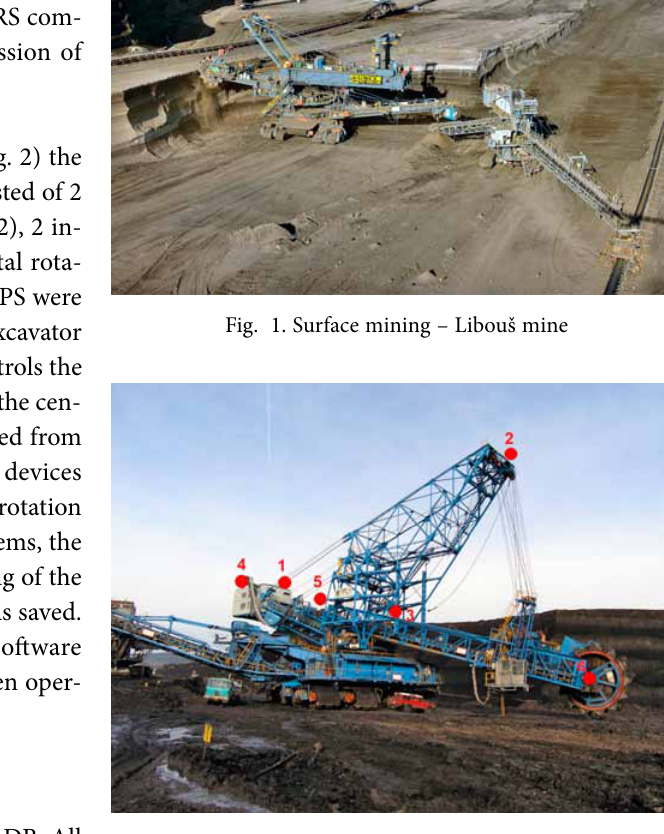
Fig. 2. K800/103 excavator